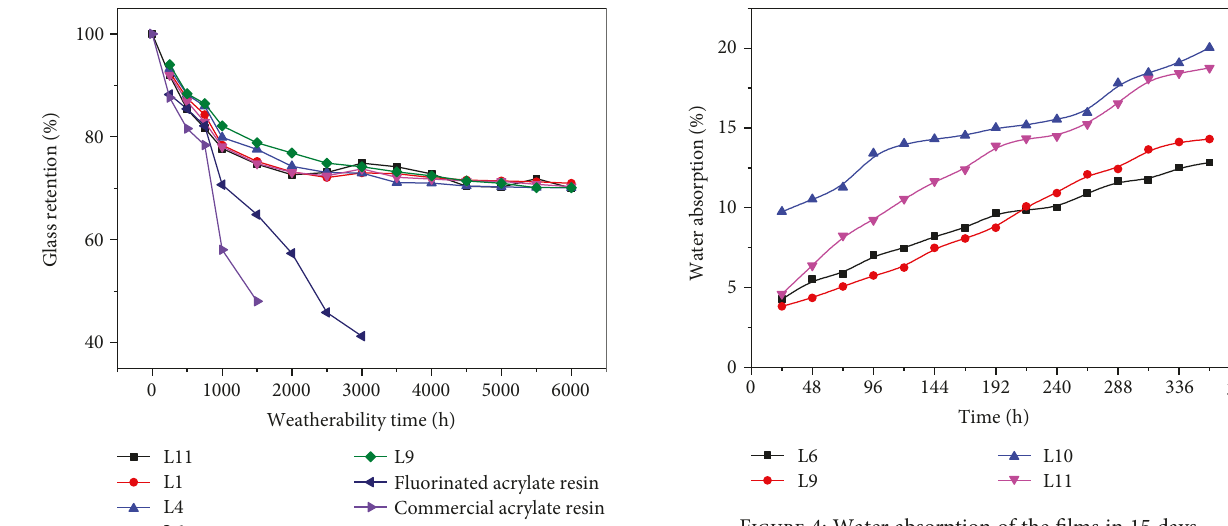
Figure 4: Water absorption of the fi lms in 15